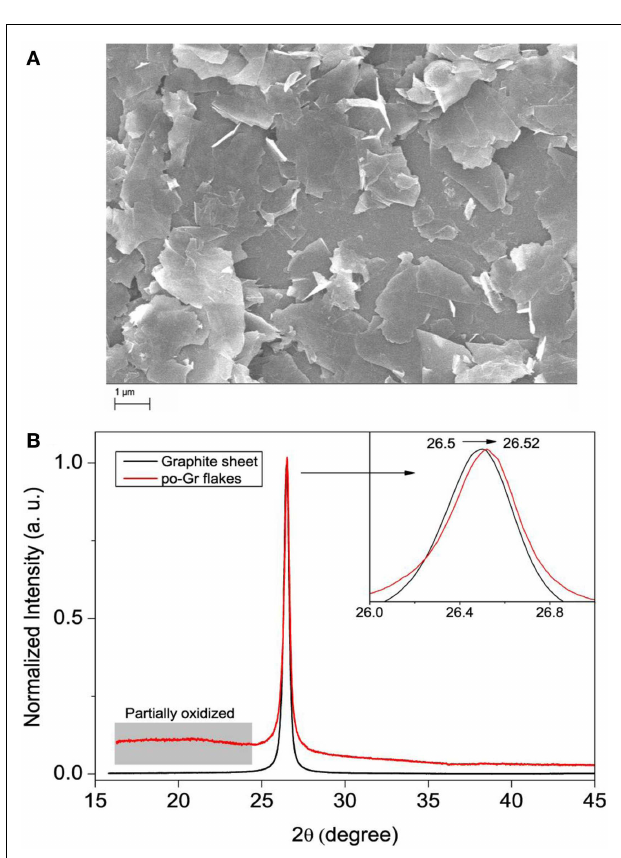
FIGURE 5 | (A) SEM image of po-Gr sheets and (B) XRD patterns of pristine graphite sheet and po-Gr flakes (inset shows enlarged view of